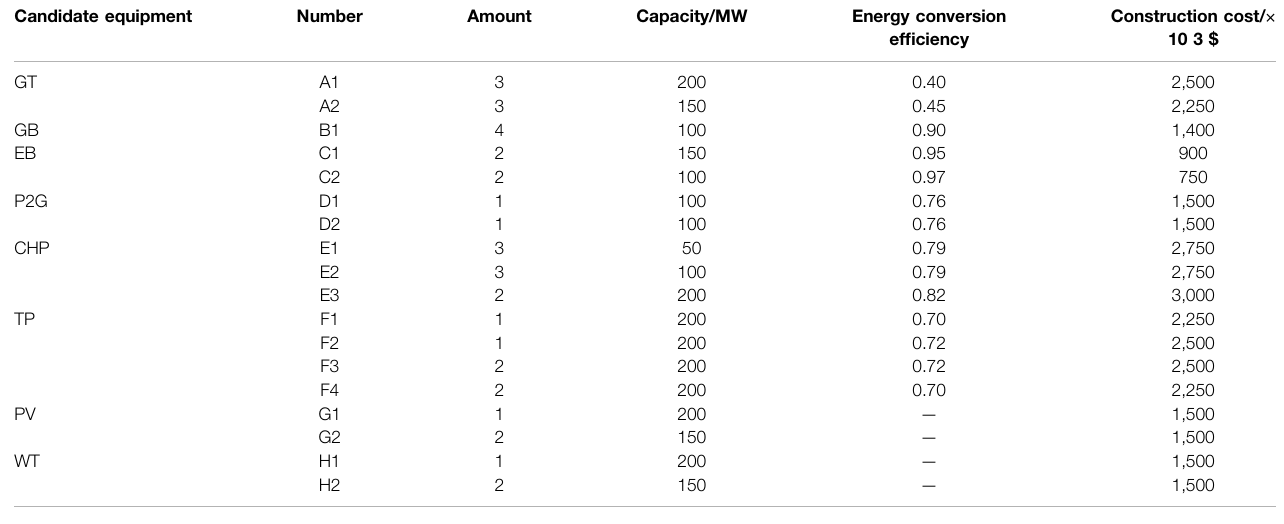
TABLE 1 | Parameter list of equipment to be selected. Candidate equipment